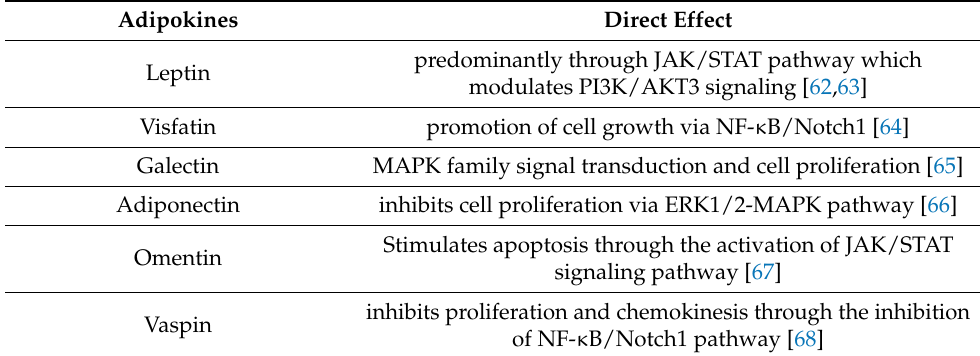
Table 2. Direct and indirect effects of adipokines on the pathogenesis of endometrial cancer.